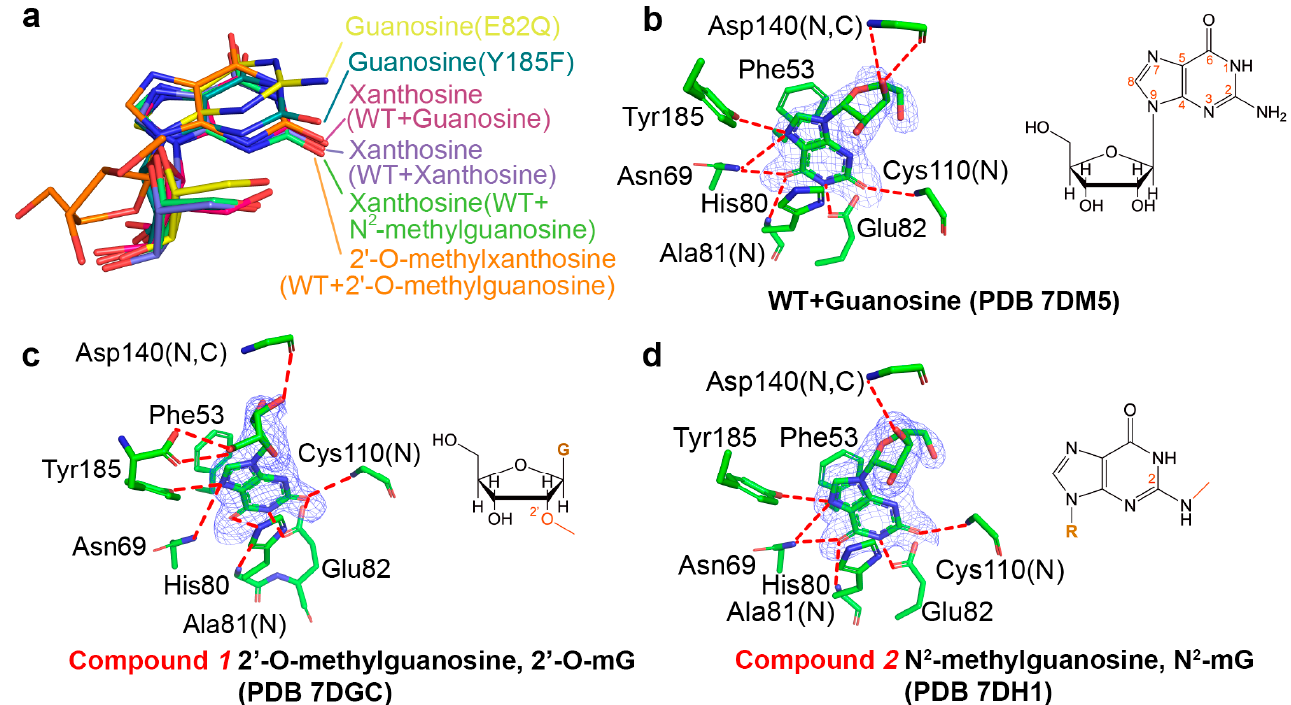
Figure 1. The binding modes of various substrates. ( a ) The superimposition of different ligands after the reactions with the WT enzyme or Y185F. The reaction products for guanosine, 2 ′ -O-methylguanosine, N 2 -methylguanosine all nearly coincide with xanthosine. ( b – d ) The omit electron density maps showing the interactions with the ligands guanosine ( b ), 2 ′ -O-methylguanosine ( c ), N 2 -methylguanosine ( d ). The omit-maps are contoured at 3 σ . The chemical structures of the ligands are drawn with their unique parts in red. G: guanine; R: ribose.